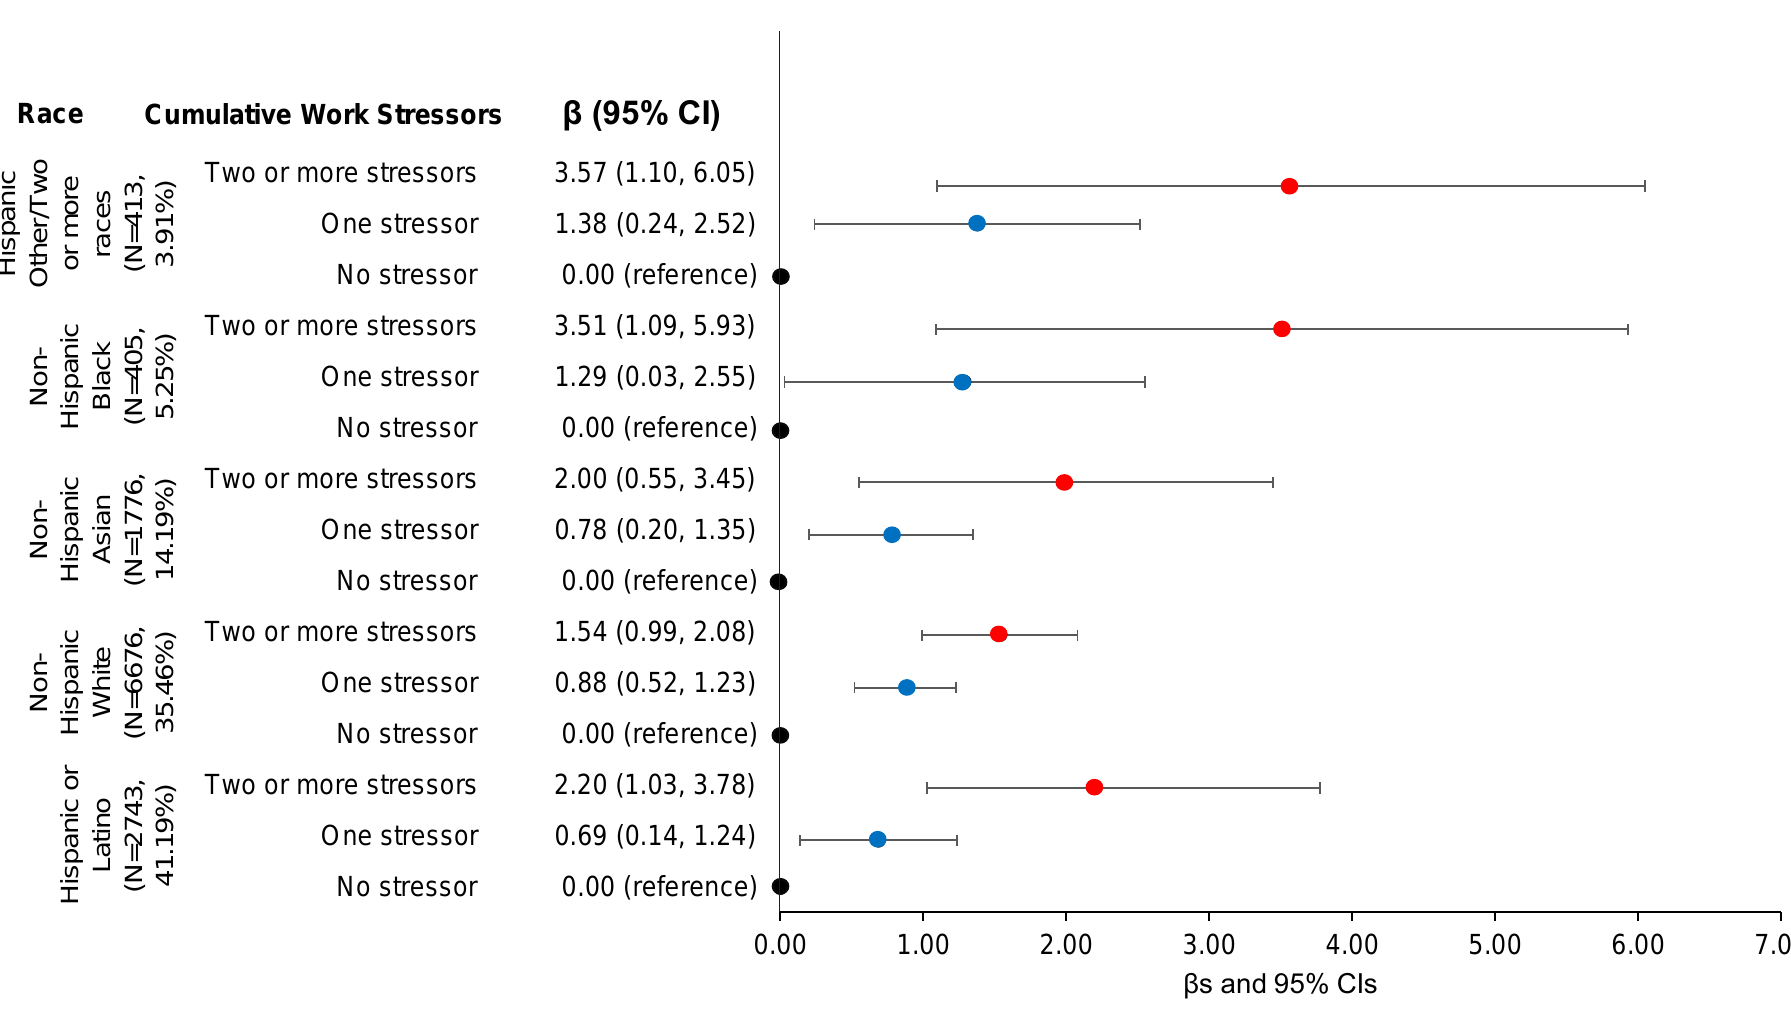
Figure 2. Associations of Cumulative Work Stressors with Psychological Distress by Race ( β s and 95% CIs) ( N = 12,113). Multivariable linear regression, adjusted for age, sex, marital status, educational attainment, household income, insurance, and citizenship.